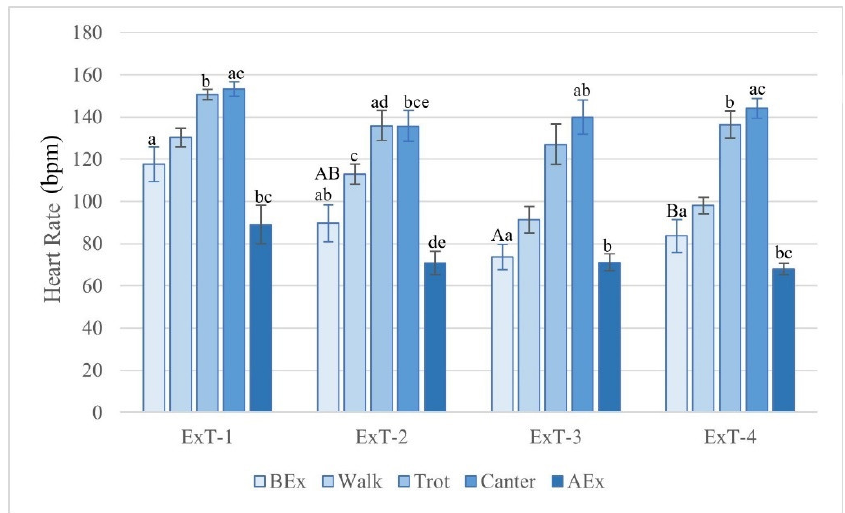
Figure 1. Heart rates measured in different phases of exercise tests 1 to 4. Legend: bpm—beats per minute; ExT-1 to ExT-4—exercise tests 1 to 4; BEx—before exercise; AEx—after exercise. a,b,c,d,e p < 0.001 (for values with the same label within a test). A, B p < 0.001 (for values with the same label within the same phase of different tests).